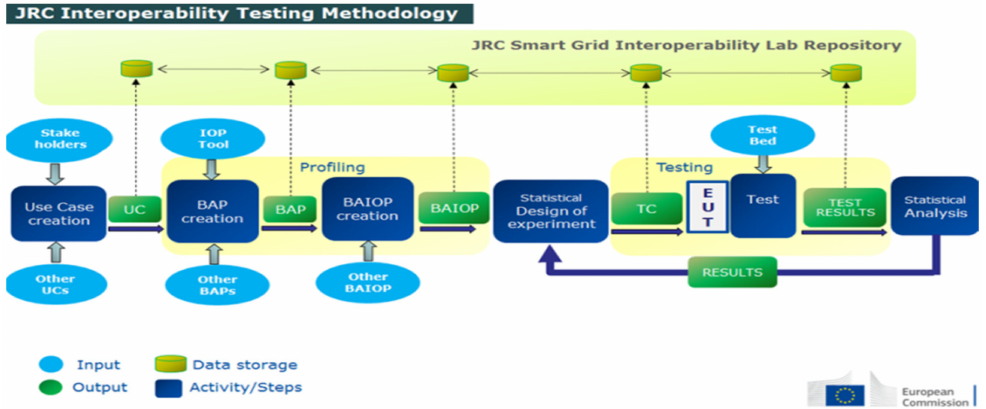
Figure 1. Interoperability Testing Methodology [1]. UC: Use Case, BAP: Basic Application